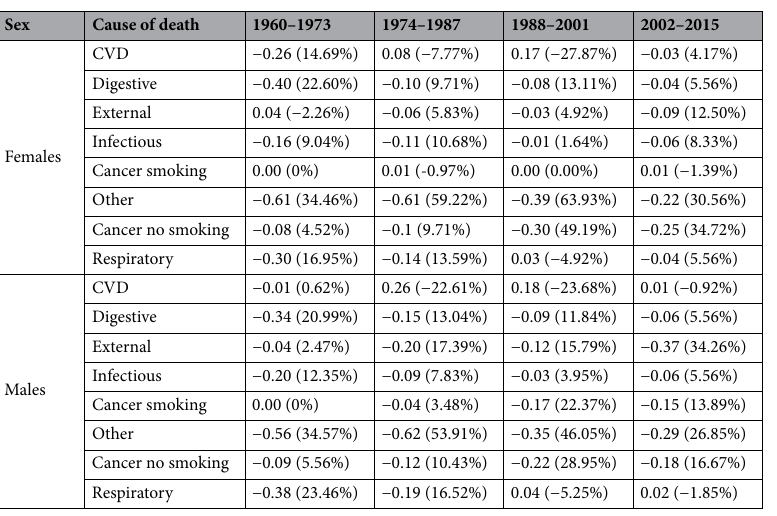
Table 2. Lifespan inequality absolute and percentage contributions aggregated over ages and specific by causes of